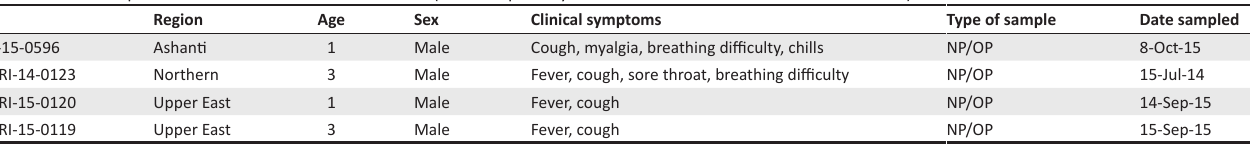
FIGURE 2: Frequency of clinical symptoms reported from 182 patients tested. TABLE 3: Details of patients with enterovirus D68 infection. (acute respiratory infections cases received from 2014 to